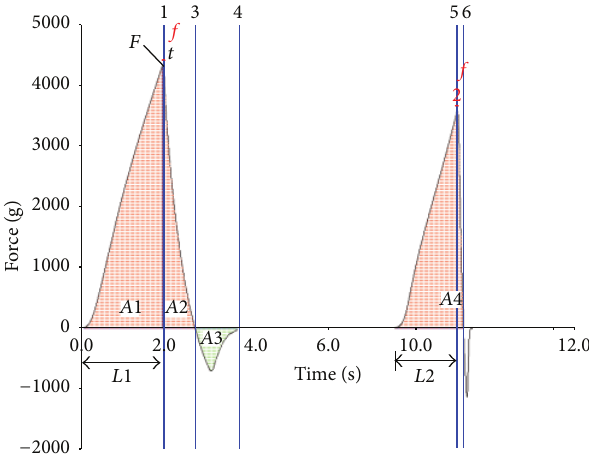
Figure 1: Texture profile analysis curve of sliced cheese. The calculation of textural properties: firmness = F (g), springiness = L 2/ L 1, cohesiveness = A 4/( A 1 + A 2), adhesiveness = A 3 (g ⋅ s), resilience = A 2/ A 1, and chewiness = firmness × cohesiveness × springiness